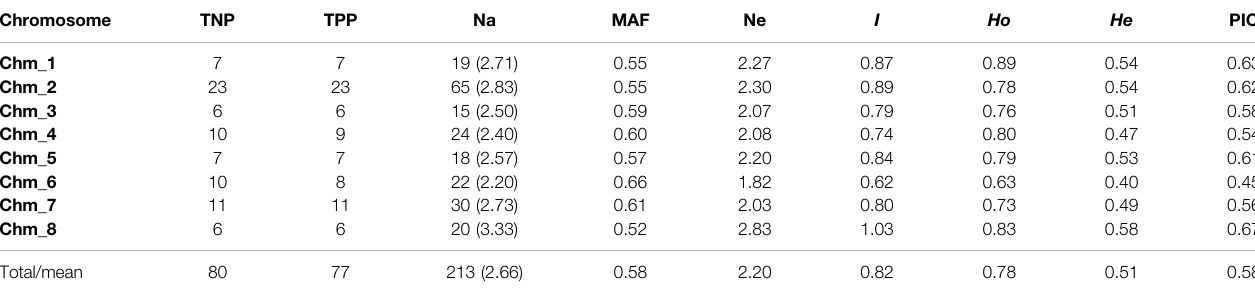
TABLE 3 | Chromosome speci fi c marker statistics for 80 miRNA-SSR primers assayed through ePCR across the four pomegranate genotypes based on their genome sequences. Chromosome TNP TPP